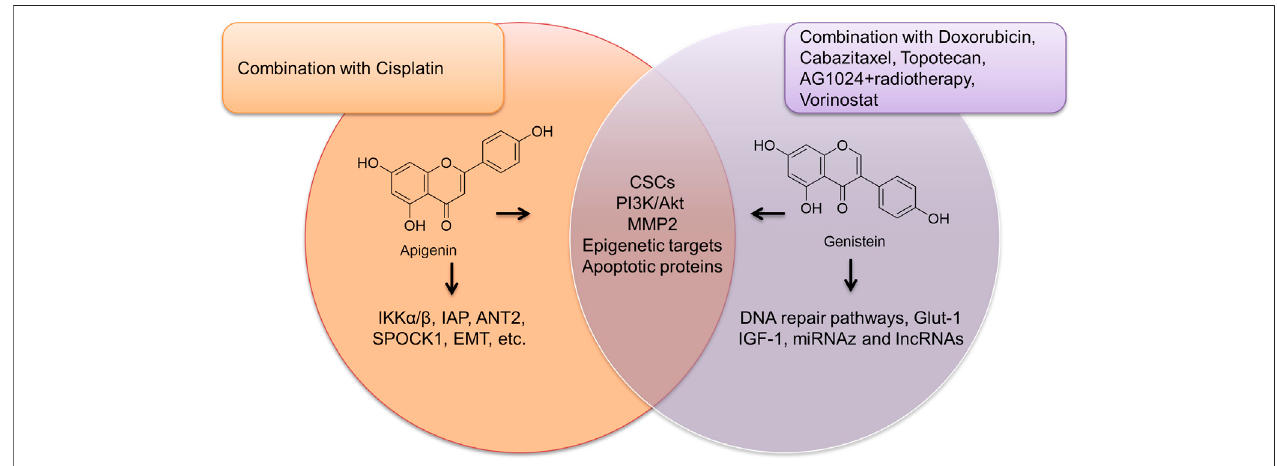
FIGURE 2 | The overview of apigenin and genistein in PCa